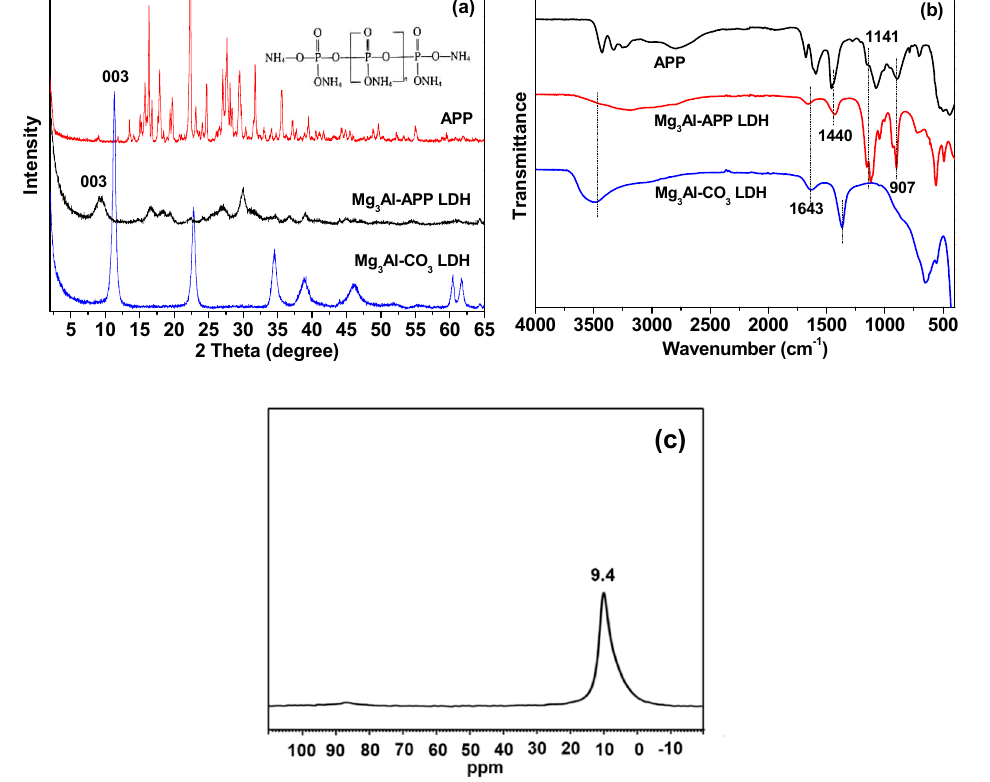
Figure 1. ( a ) X-ray diffraction (XRD) patterns of APP, Mg 3 Al-CO 3 LDH, and Mg 3 Al-APP LDH; ( b ) FT–IR spectrum of APP, Mg 3 Al-CO 3 LDH, and Mg 3 Al-APP LDH; and ( c ) 27 Al solid NMR spectra of LDH.